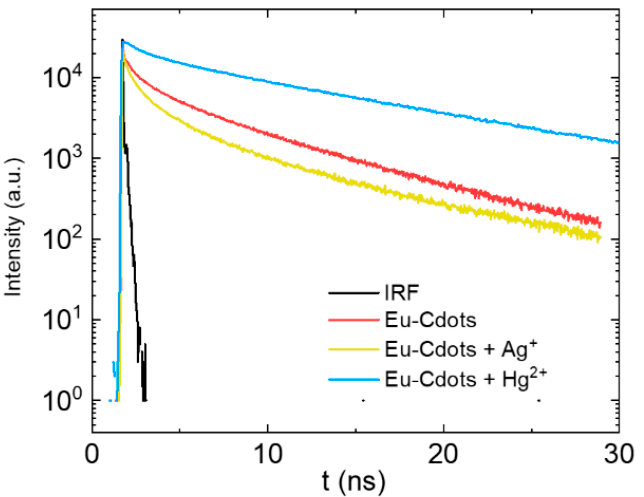
Figure 6. Emission decay curves for Eu-Cdots ( red ), and Eu-Cdots in the presence of 100 mM of Ag + ( yellow ) and Hg 2+ ( blue ). The instrumental response function (IRF) is shown in black.